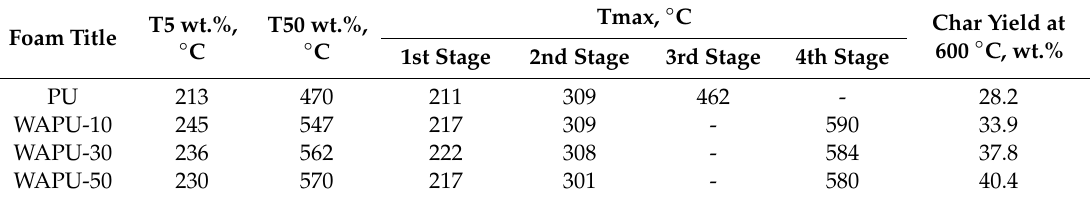
Table 3. Thermal degradation parameters of PU and WAPU foams from TGA